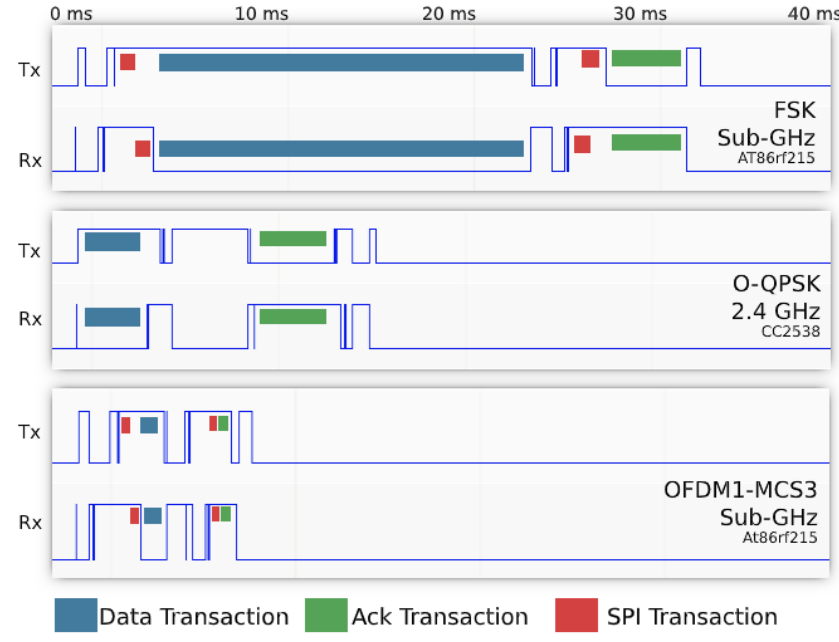
Figure 1. Timeslot templates for the three PHYs. We use a 40 ms timeslot duration in all cases.